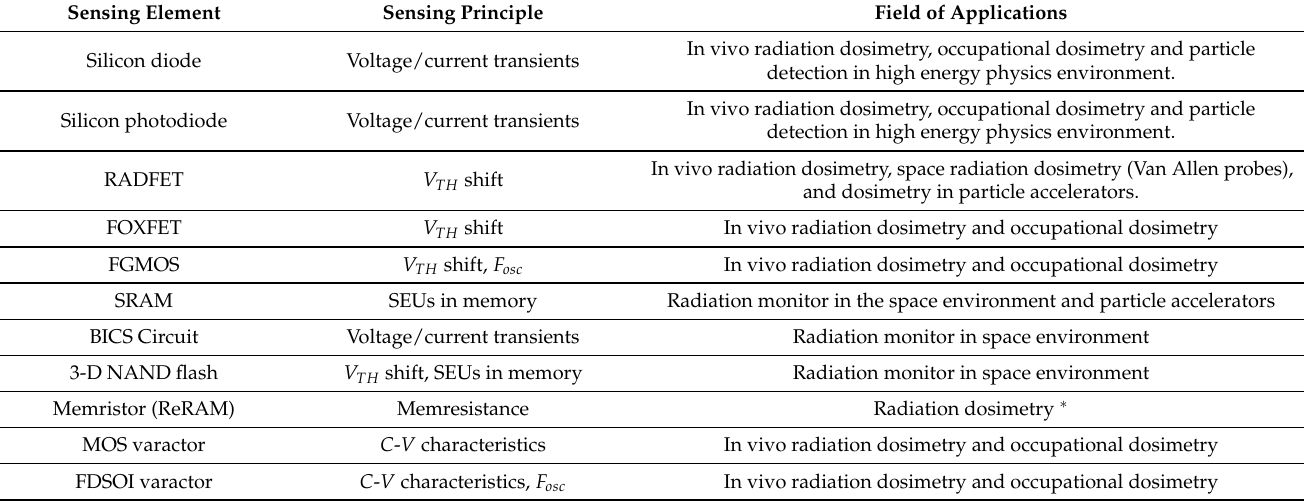
Table 2. Summary of sensing principles and field of applications of the different semiconductor based radiation sensors. Sensing